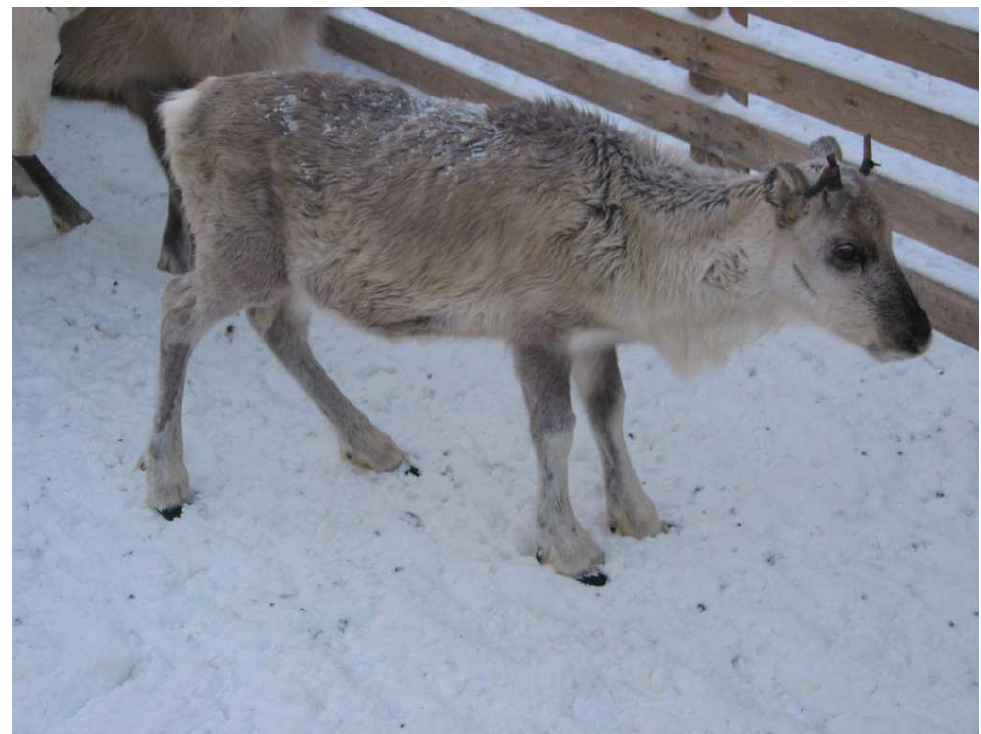
Fig. 3. Reindeer calf suffering from heavy Setaria tundra infection. Note poor body condition with poor fur quality and distended